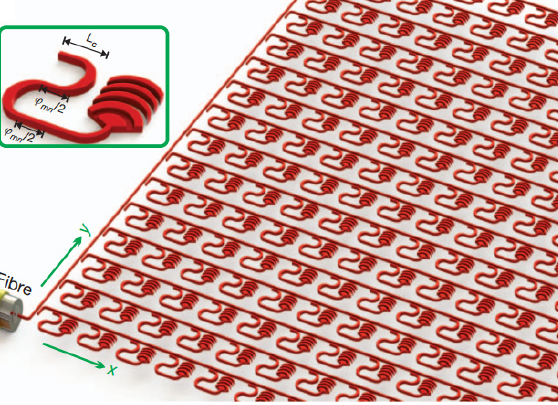
Figure 7. The architecture of the large-scale integrated 2D optical phased antenna array from [69]. Reproduced with permission from [69].